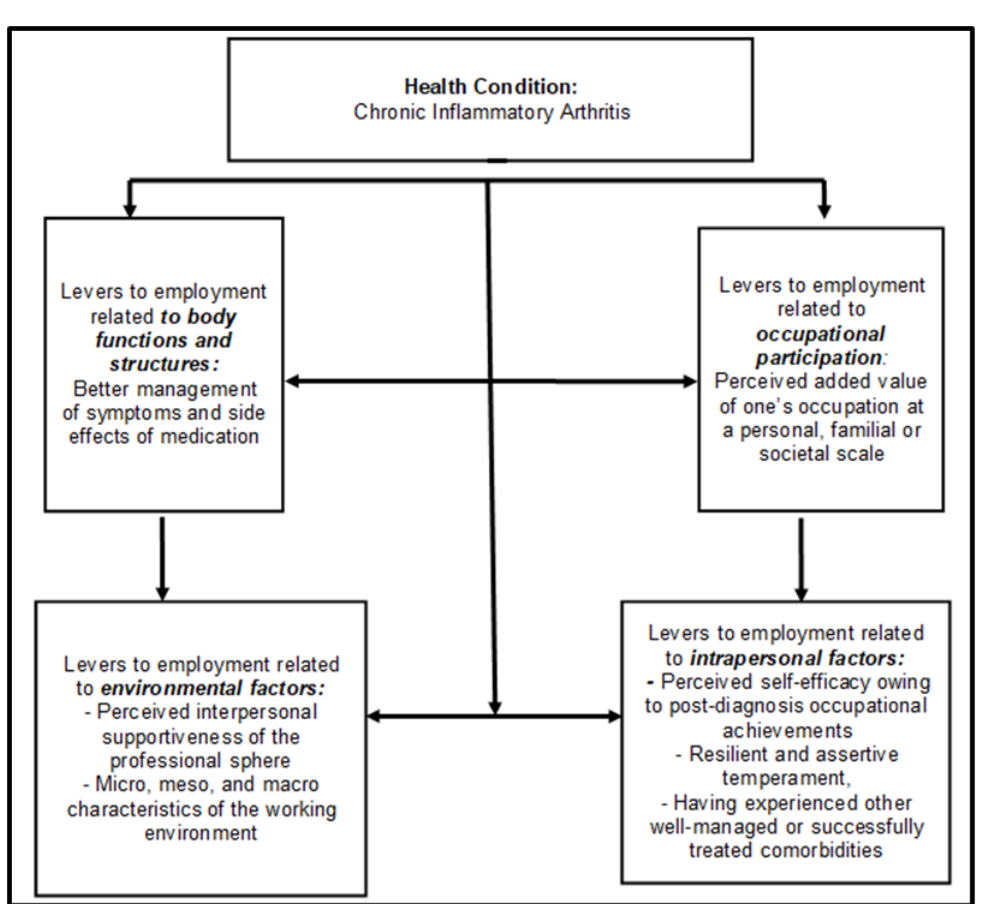
Figure 2. Levers for employment of patients with IA structured in accordance with the ICF – WHO model.